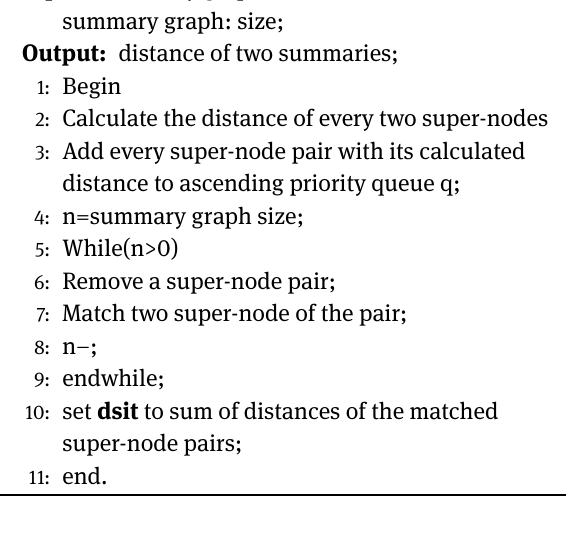
Algorithm2: Calculating distance two summary graphs